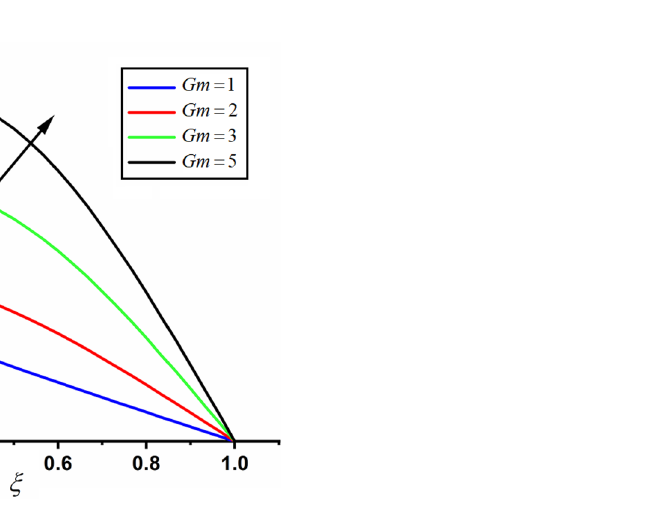
Figure 5. The impact of Gr on fractal-fractional couple stress fluid velocity in channel when, α = 0.5 , β = 0.5 , Gm = 3 , M = 2 , K = 3 , η A = 1 , P = 1.5 , Pr = 1.5 , Re = 2.5 and Sc = 0.3 .